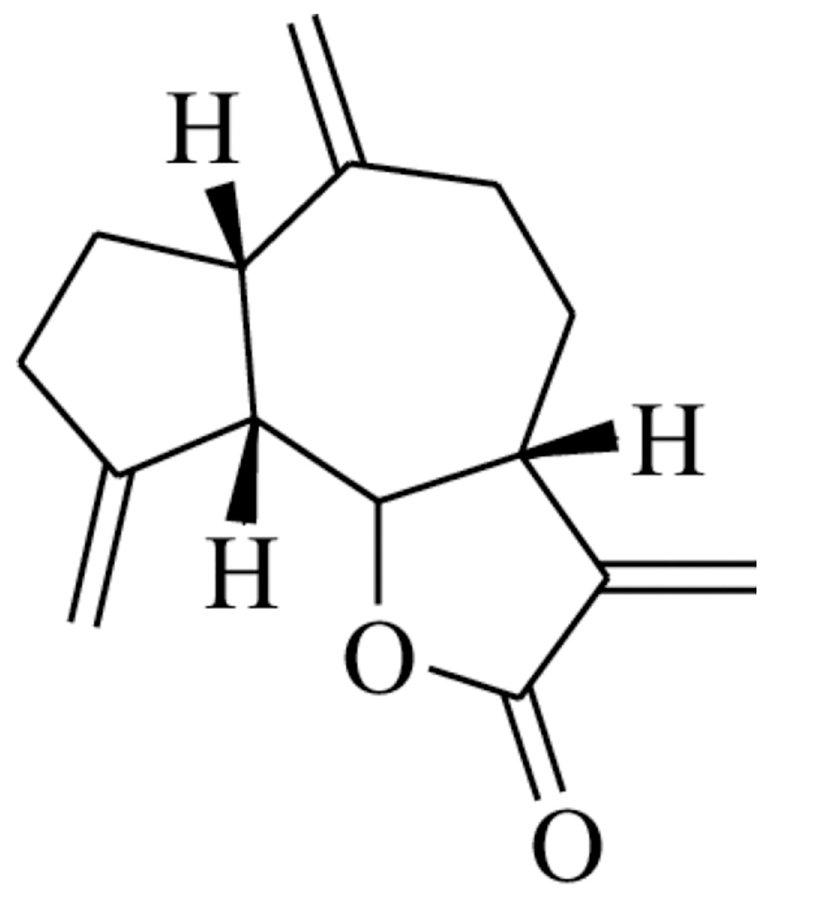
Fig 1. Structure of dehydrocostus lactone